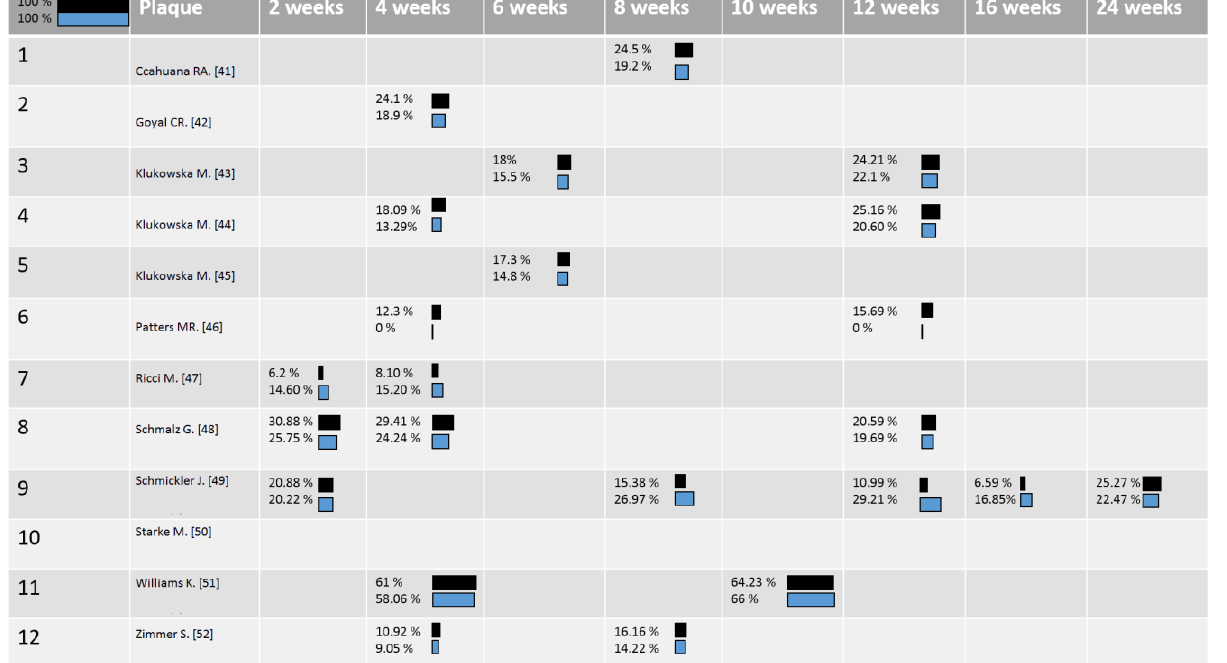
Figure 4. Plaque Index, the mean values of Plaque Index (changes) in relation to the number of patients in each study at each time-point: blue color corresponds to ORHs and black to SAHs toothbrushes [41–52].